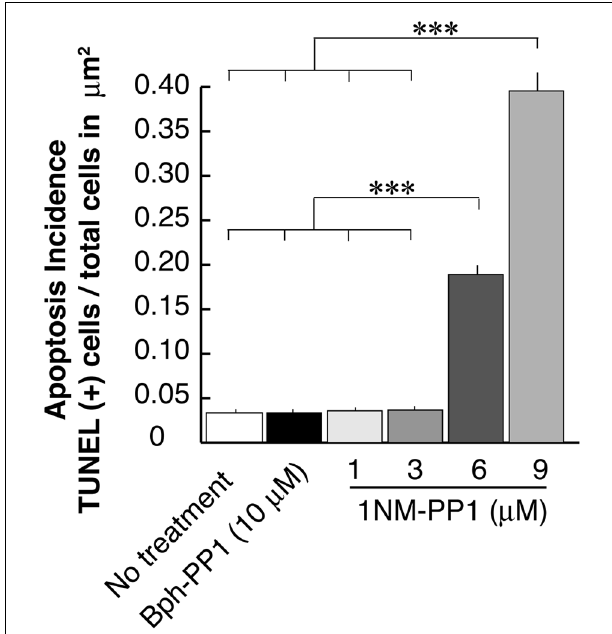
FIGURE 1 |Apoptosis rate of neurons that undergoTrkB signaling inhibition using the chemical genetic approach. Ratio’s ofTunel signal positive cells to total cell number ( ∼ 3,500–6,600 cells examined in 250 μ m × 250 μ m from eight cultures for each condition) are presented. Error bars represent